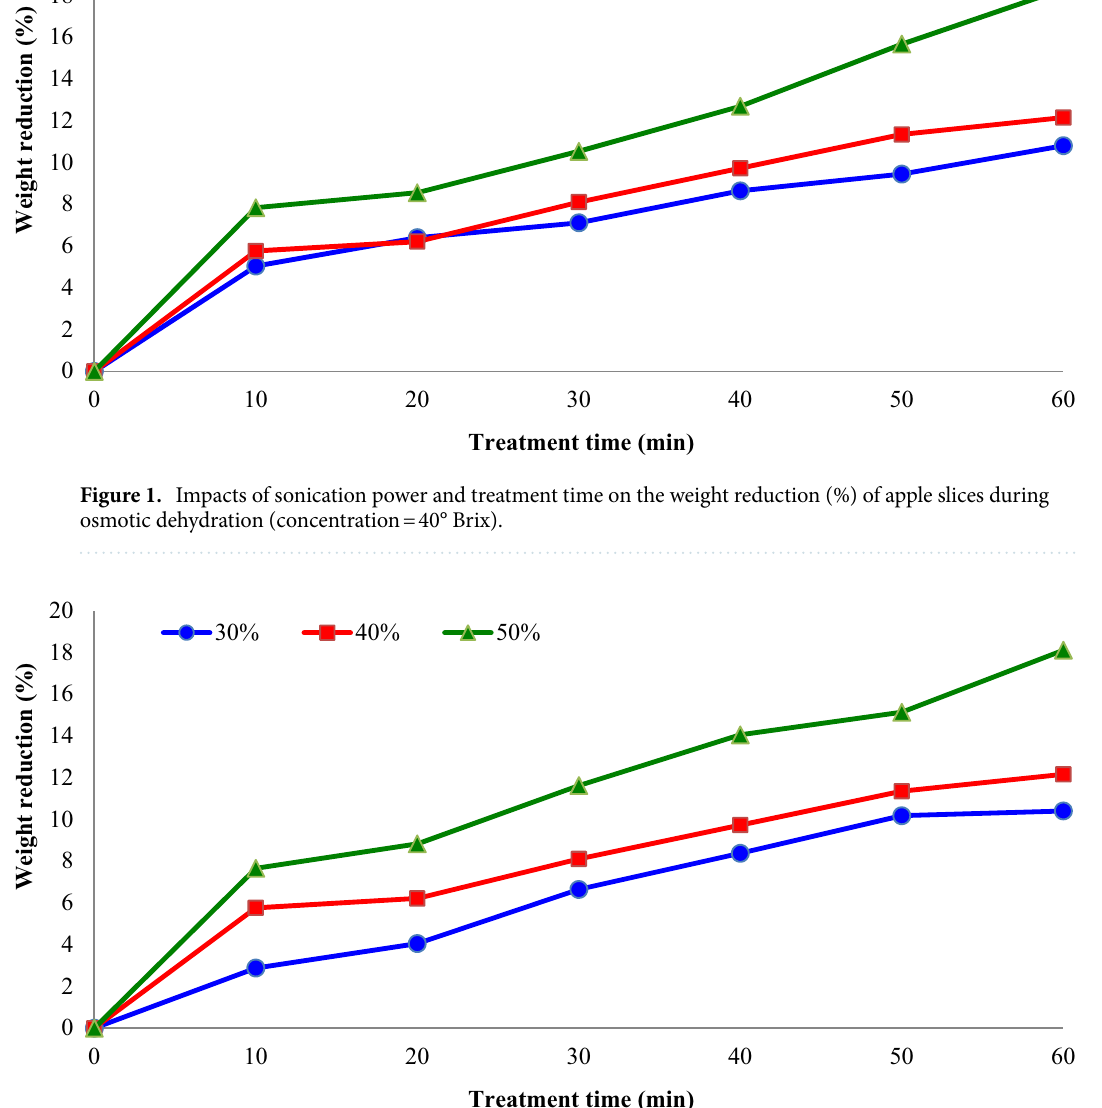
Figure 2. Impacts of sucrose solution concentration (°Brix) and treatment time on the weight reduction (%) of apple slices during osmotic dehydration (sonication power = 75